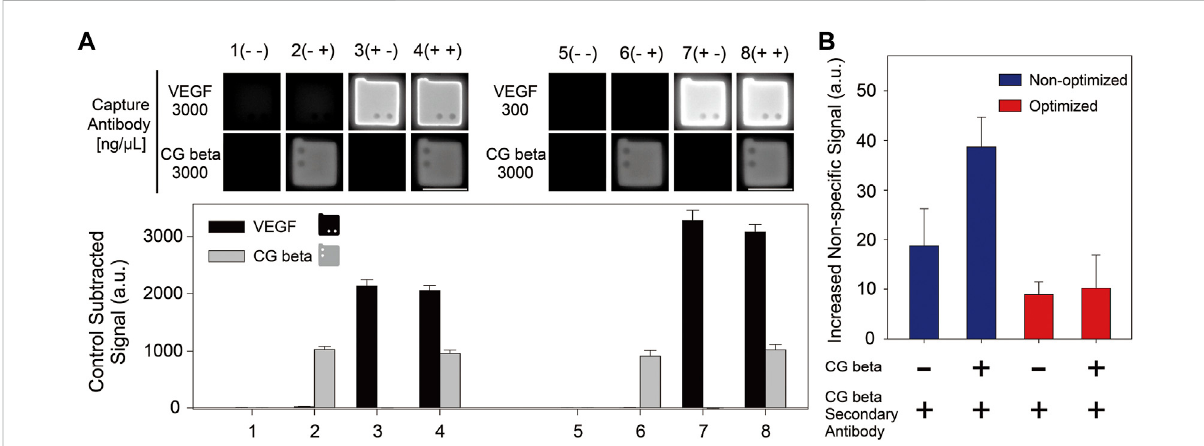
FIGURE 4 (A) Multiplex immunoassay results for VEGF and CG beta targets. Two sets of multiplex detection were conducted, using particles incubated 300 ng/ μ l and 3,000 ng/ μ Lof VEGFcapture antibodies, and 3,000 ng/ μ l ofCG beta capture antibodies during post-synthesis functionalization.The spike-inconcentrationsforVEGFandCGbetatargetwere512 pg/mland256 pg/ml,respectively.Thescalebarsare100 μ m. (B) Theincreasednon- speci fi csignalsoftheparticlesfunctionalizedwithVEGFcaptureantibodiesinmultiplexassayinducedbyantigenandsecondaryantibodyofCG beta. The increased non-speci fi c signals was calculated by subtracting each control signal of the particles conjugated with VEGF capture antibodies in the singleplex assays from the control signals of the particles in the multiplex assay.